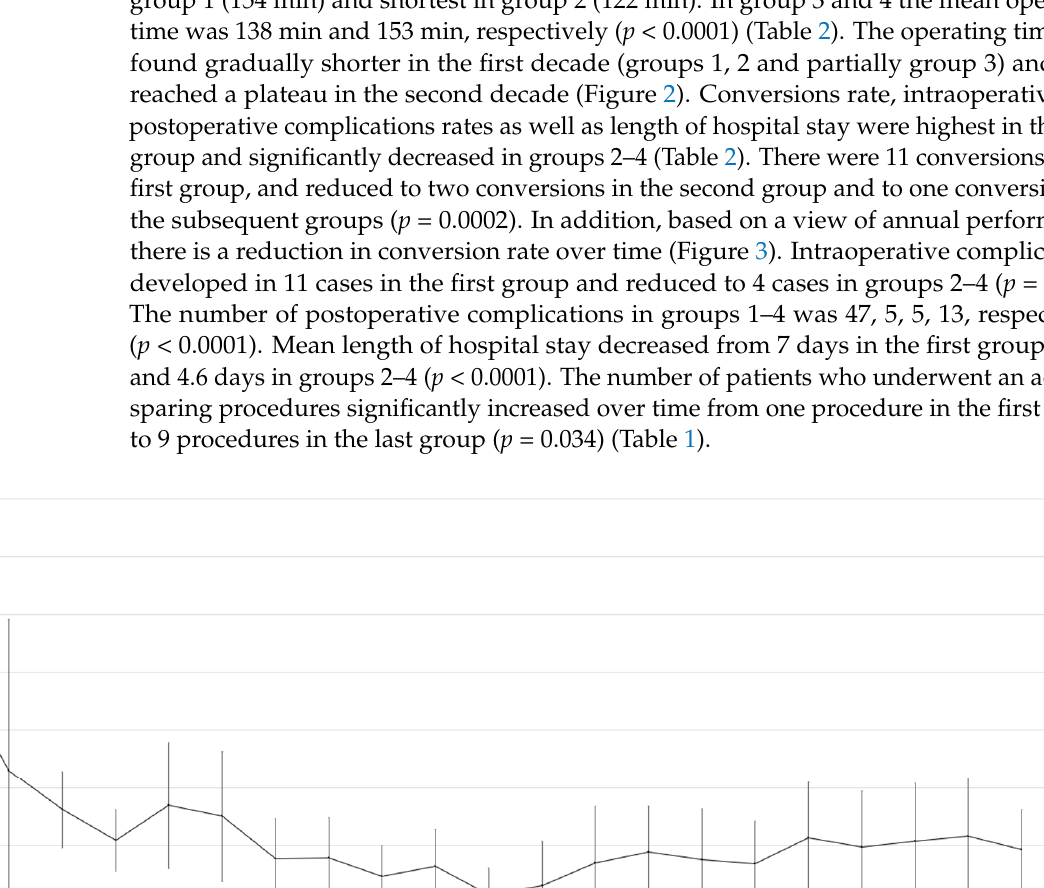
Figure 2. Annual mean operating time of unilateral laparoscopic adrenalectomy (excluded: bilateral adrenalectomies, conversion to open surgery, adrenal-sparing procedures, additional procedures performed).